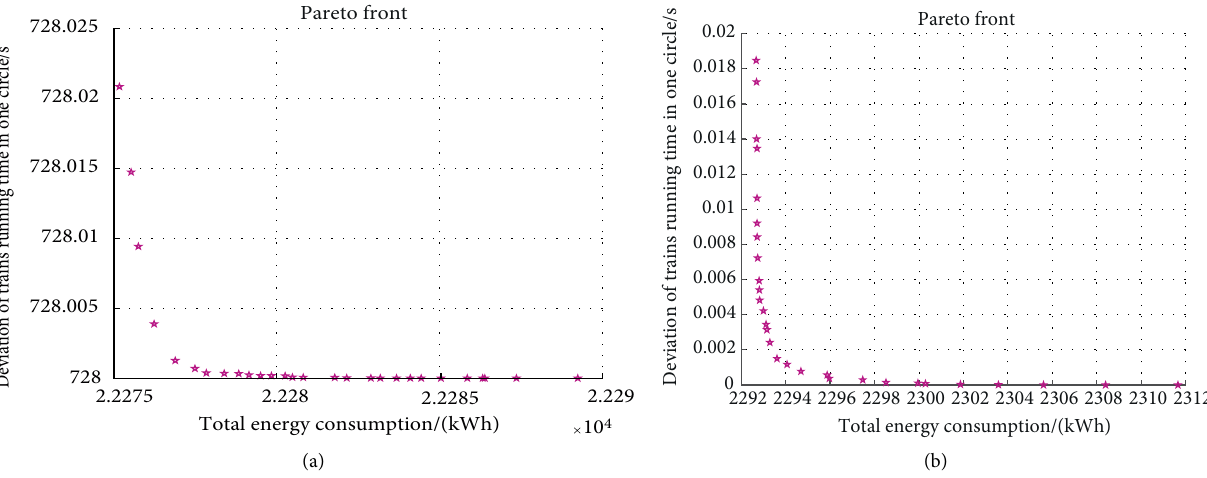
Figure 22: The Pareto front under and OIC = 0.3. (a) The Pareto solutions of the OEST. (b) The Pareto solutions of the 𝐺 = 250